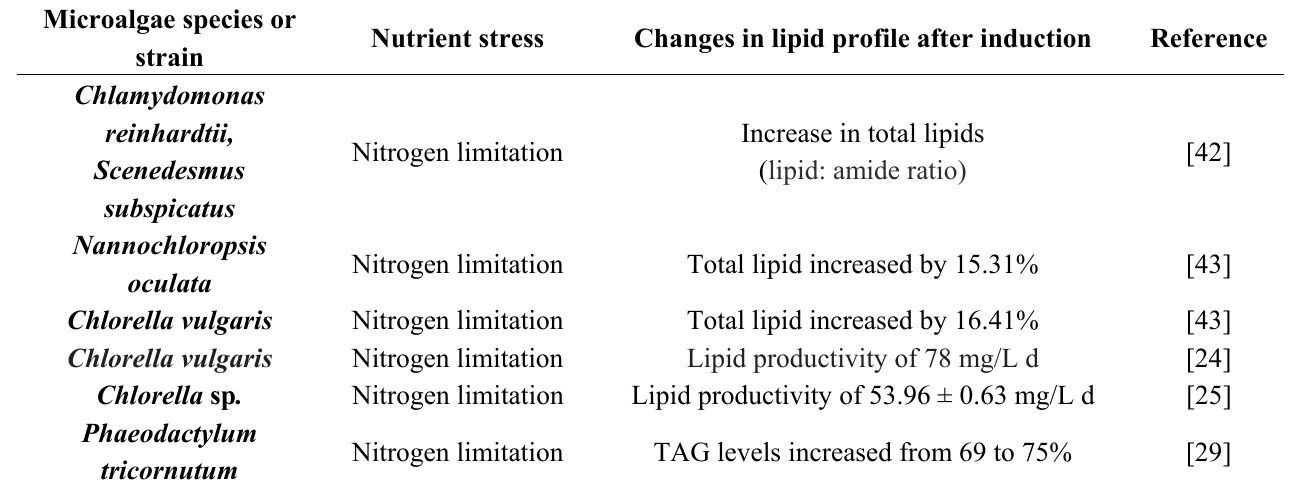
Table 1. Examples of different types of nutrient starvation stress which have been studied to induce lipids in